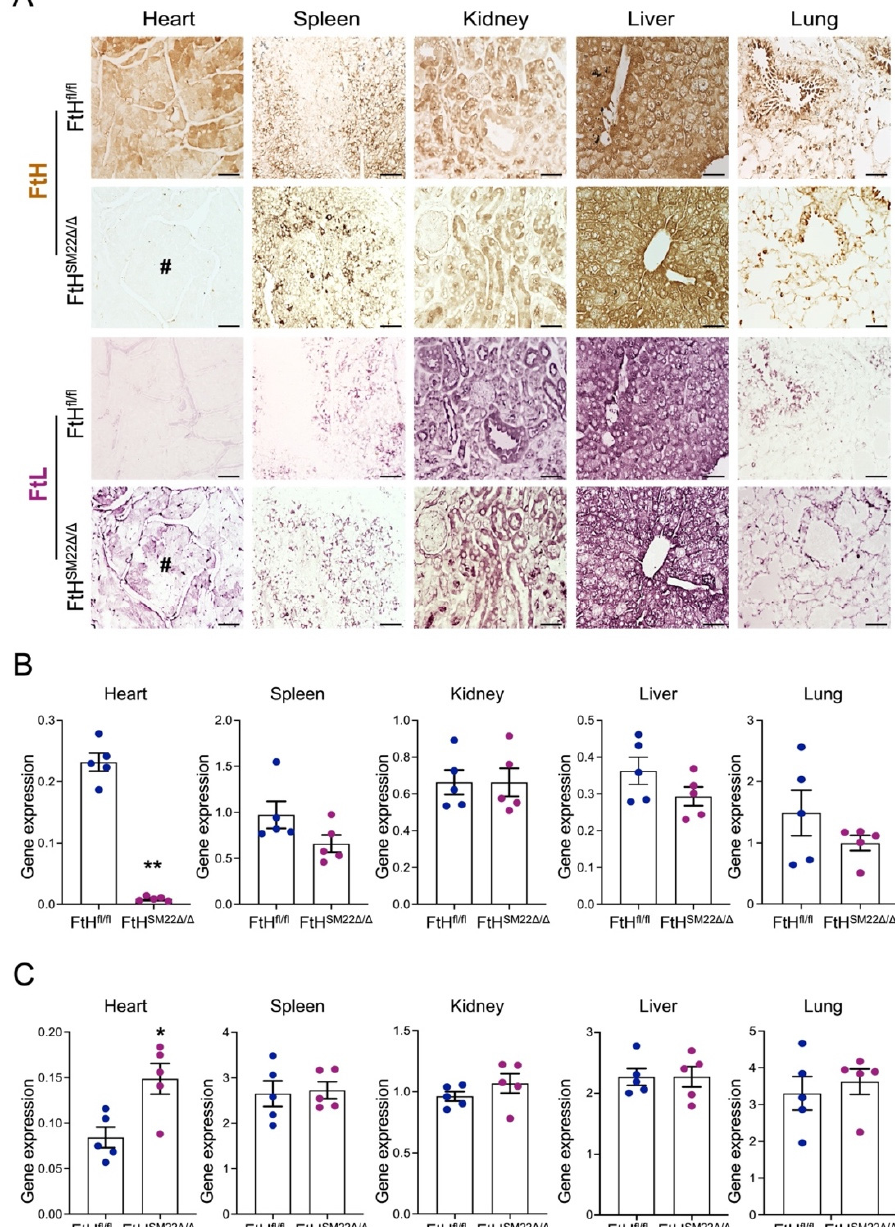
Figure 1. Establishment of FtH SM22 ∆ / ∆ mice. ( A ) Immunohistochemical staining of serial sections of heart, spleen, kidney, liver, lung tissues from FtH fl/fl and FtH SM22 ∆ / ∆ mice illustrating FtH (brown) and FtL (pink) expression. Scale bar = 100 μ m. # denotes lack of FtH expression in cardiomyocytes concomitant with FtL overexpression in corresponding serial section. n = 5/genotype. ( B , C ) Various organs from FtH fl/fl and FtH SM22 Δ / Δ were harvested and mRNA levels of FtH ( B ) and FtL ( C ) were examined using RT-PCR analysis. Results were normalized to GAPDH and presented as means ± SEM. * p < 0.05 and ** p < 0.01. n = 5/genotype.